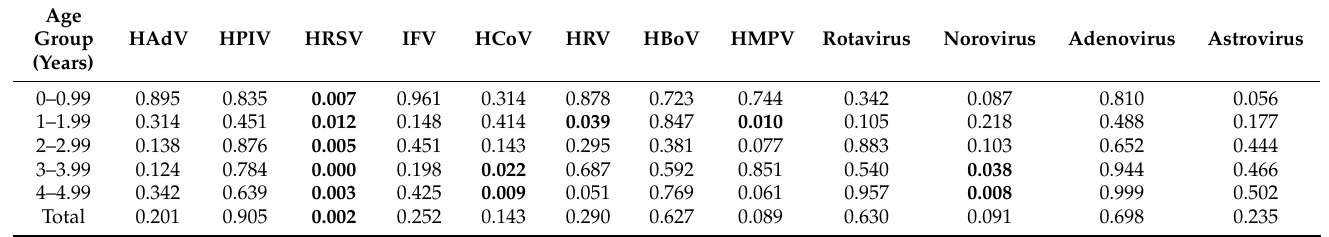
Table 4. Analysis of the correlation between the incidence of febrile convulsion by age and the positive rate of the virus.